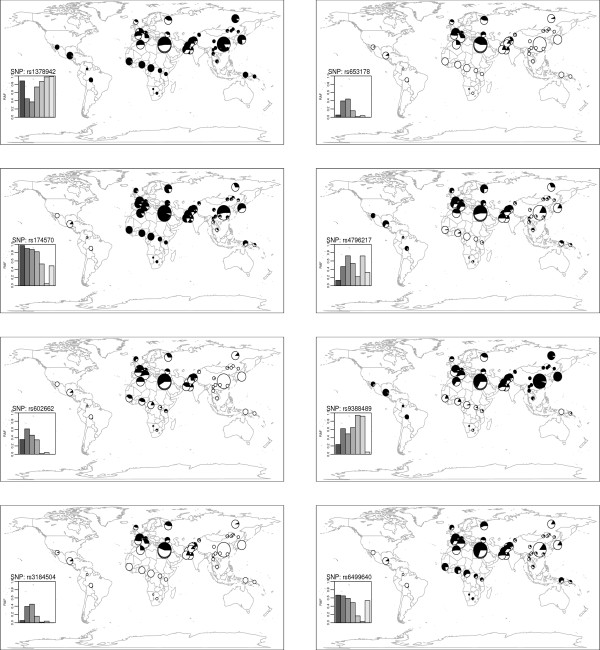
Geographical distribution of risk (black) and wild-type (white) alleles in eight SNPs with a significantly higher FST among the 52 populations. In each subplot, the radius of a pie chart represents the sample size in a given population. The inserted barplot shows the average frequency of the risk allele among the seven geographic regions. From left to right, the bars indicate Africa, Middle East, Europe, Central South Asia, East Asia, America, and Oceania, respectively.